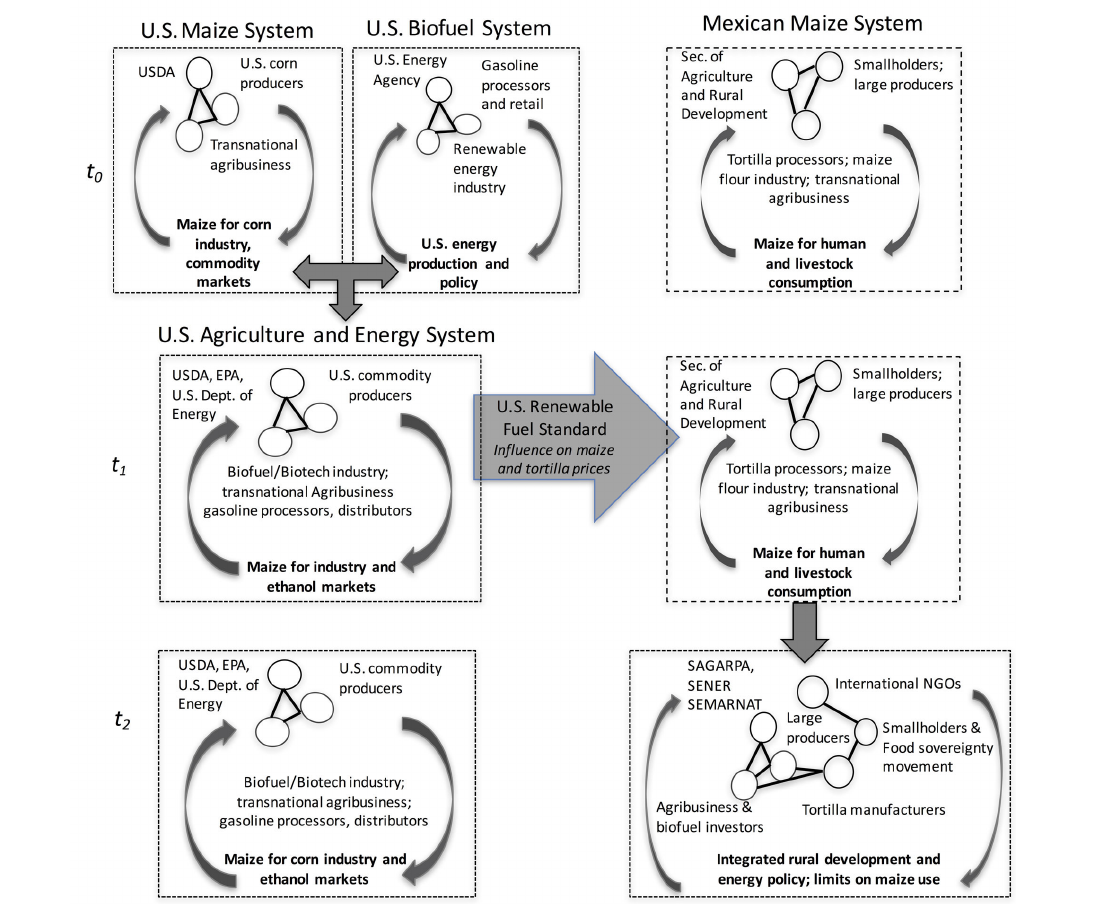
Fig. 3 . Telecoupling of U.S. Corn and Biofuel System to the Mexican Maize System. At t Mexican maize system is largely independent of influence of the U.S. energy system. At t institutional linkages between the U.S. Corn and U.S. energy system are in place; these linkages transmit a signal of change to Mexico. At t , the telecoupling of U.S. Corn Ethanol to the Mexican 2 Maize system has contributed to changes in governance and institutions in Mexico, but has not generated a feedback to the U.S. agriculture-energy